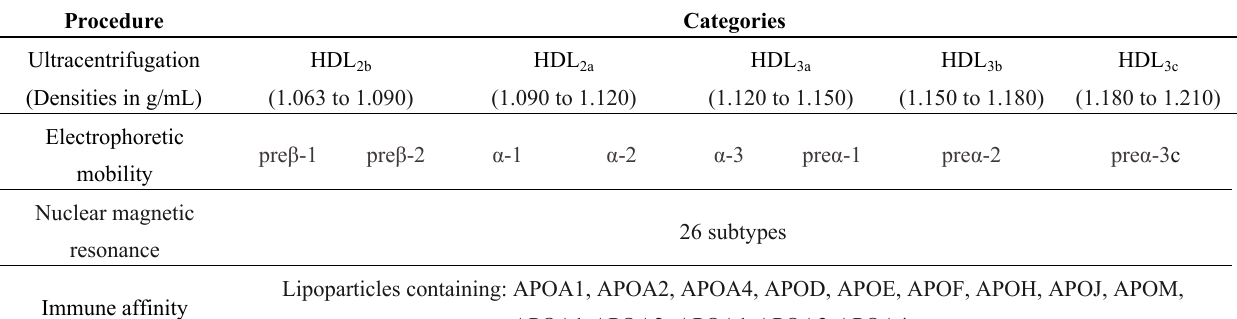
Table 1. HDL subspecies depending on analytical